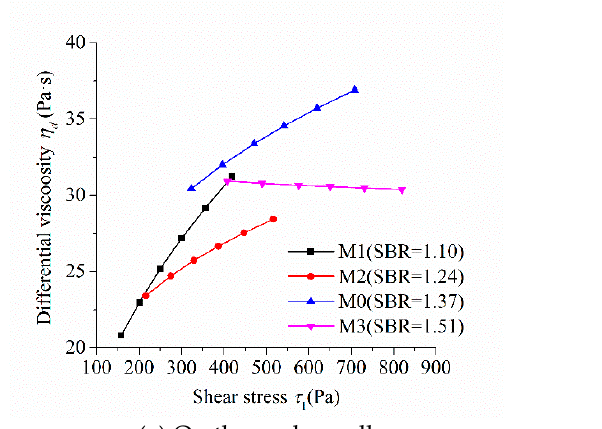
Figure 8. Relationship between the shear stress and shear strain rate of mortars with different dosages of superplasticizer (SP).